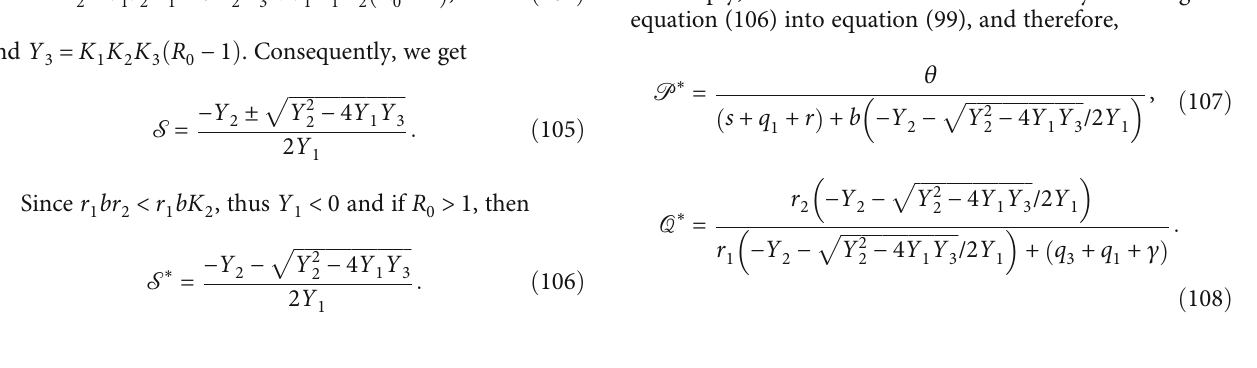
R q q 0 vs. 1 and 2 ,